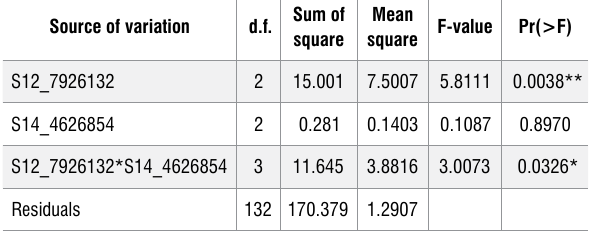
Table 3: Analysis of variance output for cassava mosaic disease severity scores Source of variation